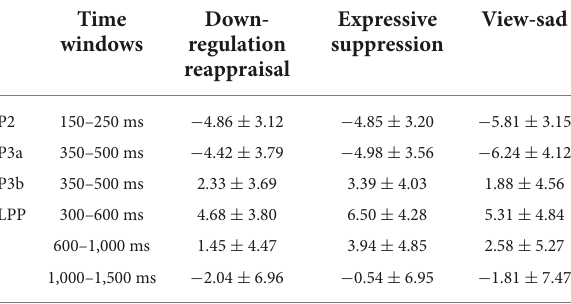
TABLE 3 The ERP average amplitude under each regulation